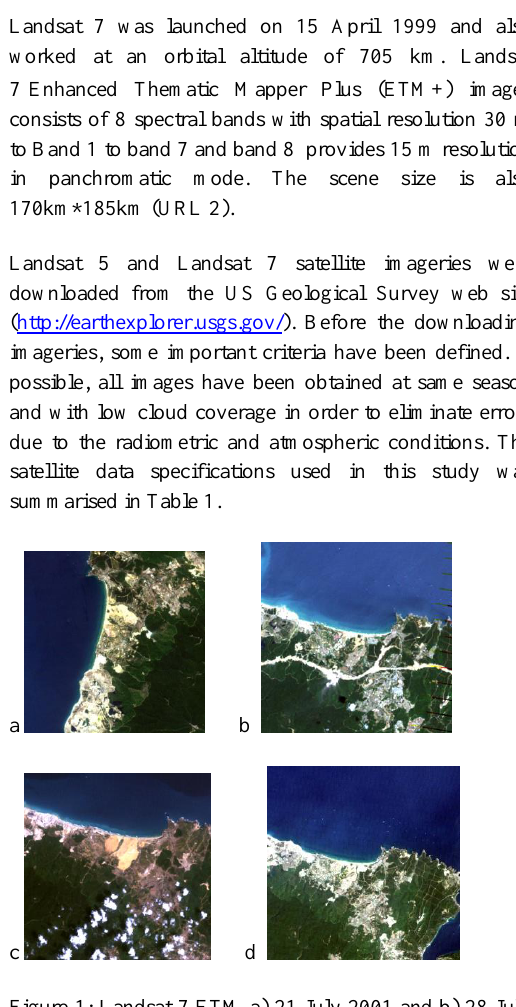
Table 1: The specification of Landsat 5 and Landsat 7